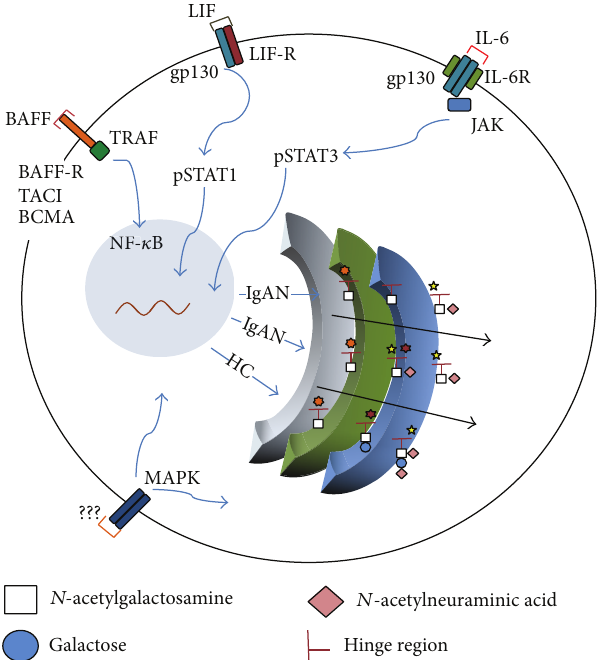
Figure 3: Examples of potential signaling mechanisms involved in the O -glycosylation of IgA1. Several signaling mechanisms likely regulate O -glycosylation patterns of IgA1 in the Golgi apparatus. In this scheme, we have highlighted examples of three types of signaling systems that are potential players in the production of galactose-deficient IgA1 (Gd-IgA1). BAFF signaling through the BAFF receptor(s) (TACI, BAFF-R, and BCMA/TRAF) prevents degradation of NF- 𝜅 B and enhances its subsequent translocation to the nucleus. This mechanism represents an example of a signaling pathway related to survival and proliferation of cells producing Gd- IgA1. Cytokine LIF, that binds the LIF-R/gp130 receptor complex, signals in B cells through STAT1 phosphorylation by JAK, followed by dimerization and translocation of the active STAT dimers to the nucleus. IL-6 activates the STAT3 pathway in B cells via JAK activa- tion at the IL-6/gp130 complex. LIF and IL-6 signaling pathways are examples of a mechanism by which environmental factors may alter expression of specific glycosyltransferases. Activation of the MAPK pathways through various intraextracellular mechanisms can lead directly to the Golgi apparatus. MAPK signaling in B cells is another example of a pathway for an environment-mediated influence to change expression of specific glycosyltransferases, to signal directly to the Golgi apparatus, or